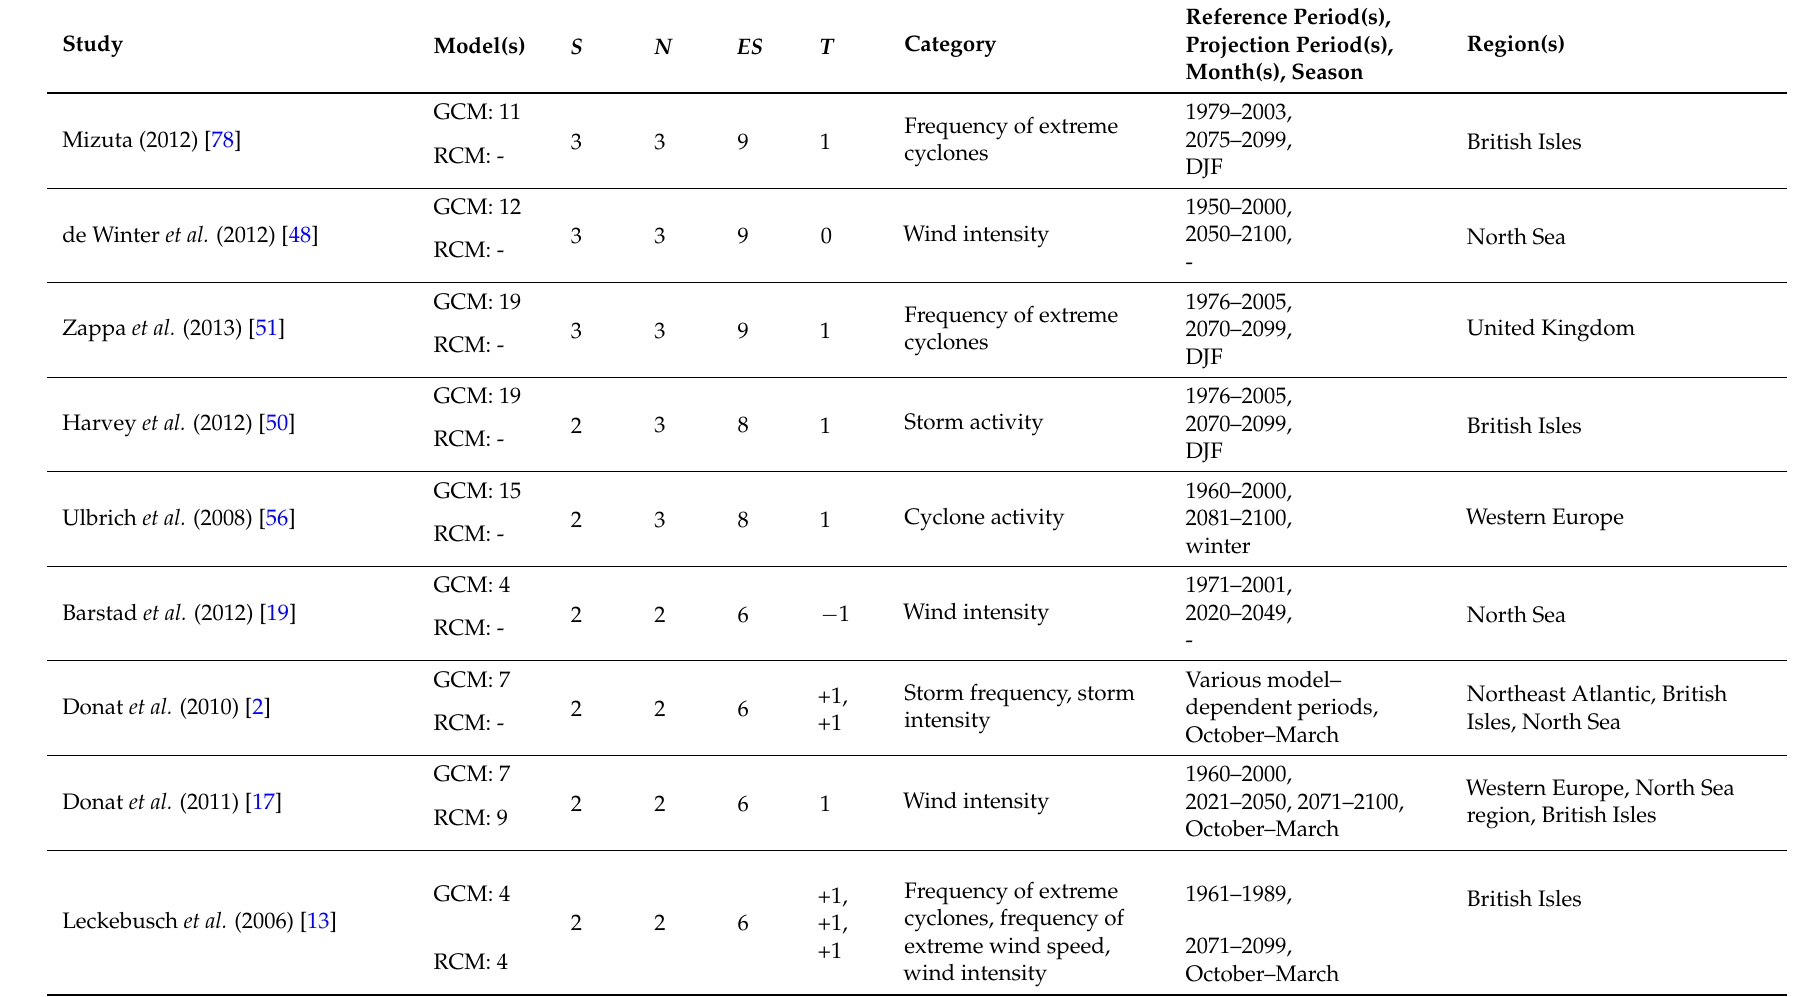
Table 6. Same as Table 1 but for the Western Europe